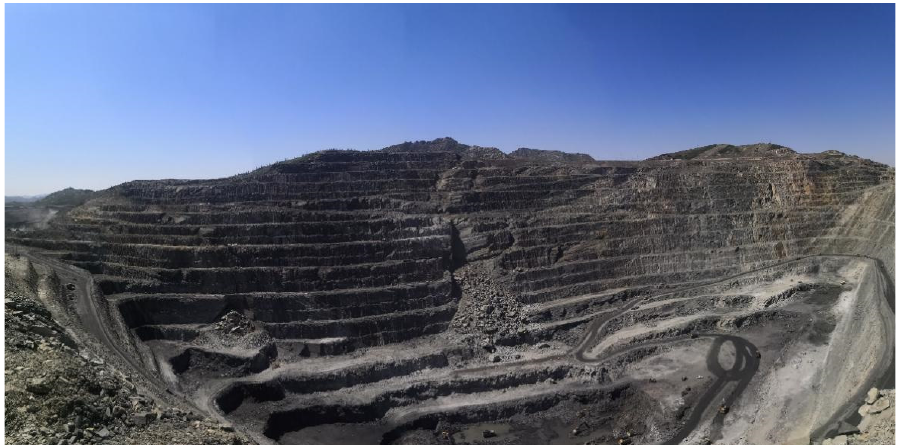
Figure 1. Open-pit mine slope from the radar perspective.